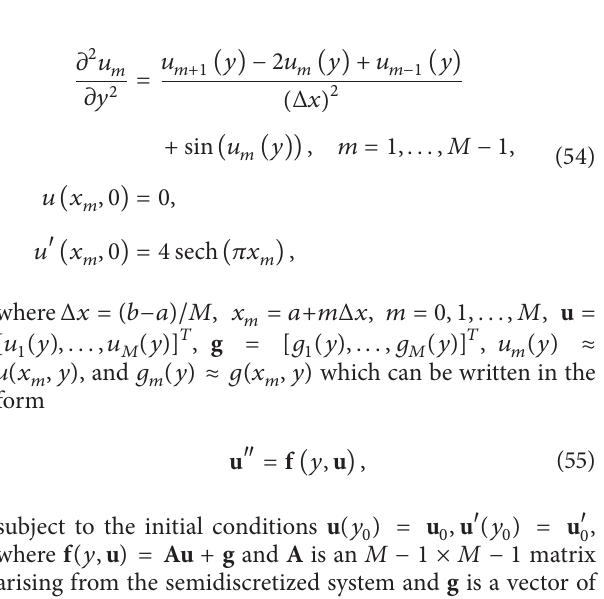
Figure 7: Plot of solution for the Sine-Gordon